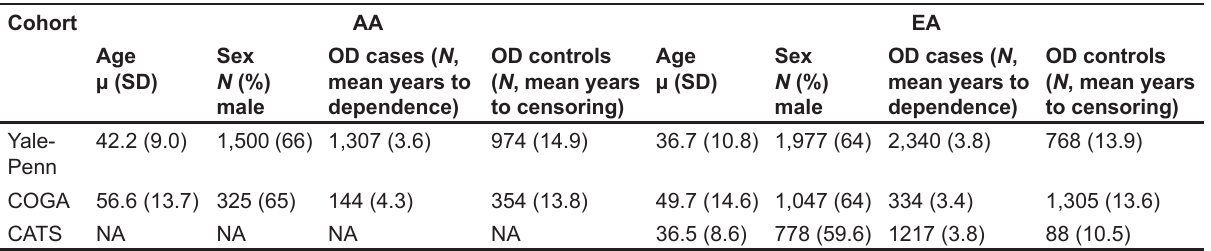
Table 2. Demographic information on cocaine exposed individuals contributing the time to cocaine use disorder analysis